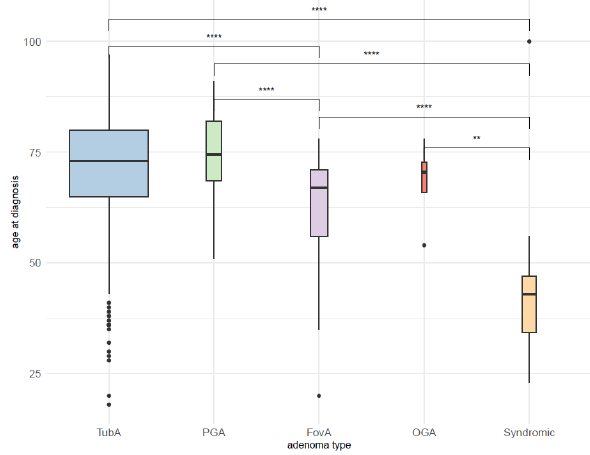
Figure 3. Distribution of age at diagnosis for each adenoma type. ****: significant difference with p -value < 0.0001; **: significant difference with p -value < 0.01; TubA: intestinal-type adenoma; PGA: pyloric gland adenoma; FovA: foveolar-type adenoma; OGA: oxyntic gland adenoma.